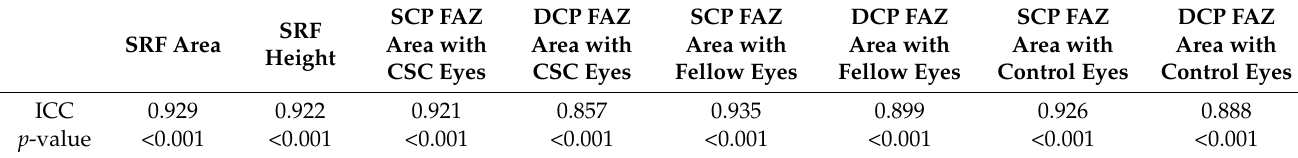
Table 4. Repeatability of SRF area and height, superficial and deep foveal avascular zone area measurements.